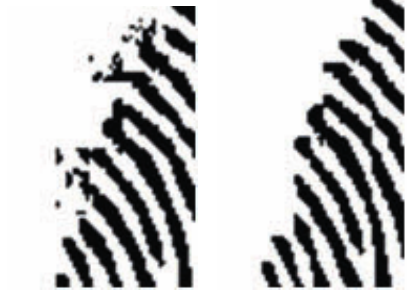
Figure 8. Comparison of quality of segmentation. Left: segmentation by [7]. Right: current